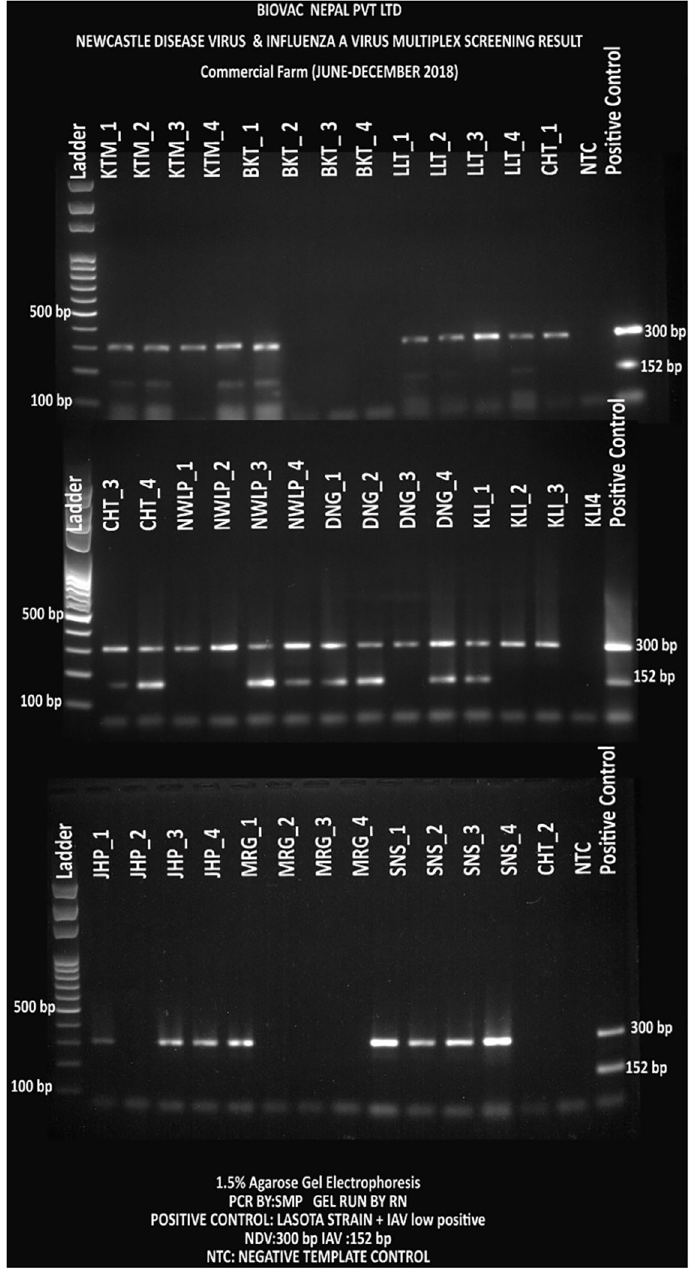
Fig 11. NDV and IAV screening PCR test in the commercial farms (n = 40)–a multiplex PCR test, NDV was detected with 300 bp and IAV with 152 bp amplicons. Each district had three letter code and included four farms (numbered 1 to 4). Each sample represents pooled samples from a single farm. The gel was run with ladder in the first well; and negative and positive controls in the last wells (from left to right). (KTM = Kathmandu, LLT = Lalitpur, CHT = Chitwan, NWLP = Nawalparasi, DNG = Dang, KLI = Kailali, MRG = Morang, and SNS = Sunsari